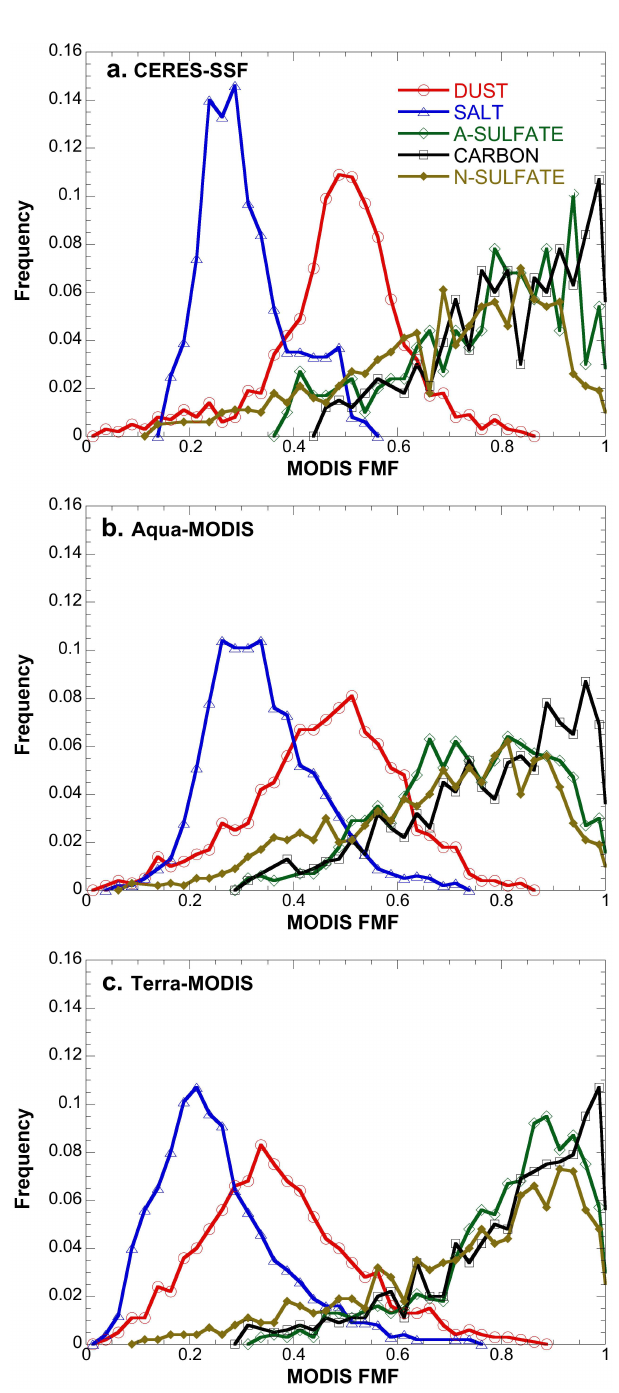
Fig. 2. (a) Frequency distribution of FMF values from the CERES- SSF dataset for 0.025 bins where at least 80% of the total GO- CART AOT is produced by an individual aerosol type. Both SS and DU have relatively uniform distributions around their mean values (0.31, 0.49). MODIS L2 Aqua and Terra data from the same time period are shown in panels (b) and (c)